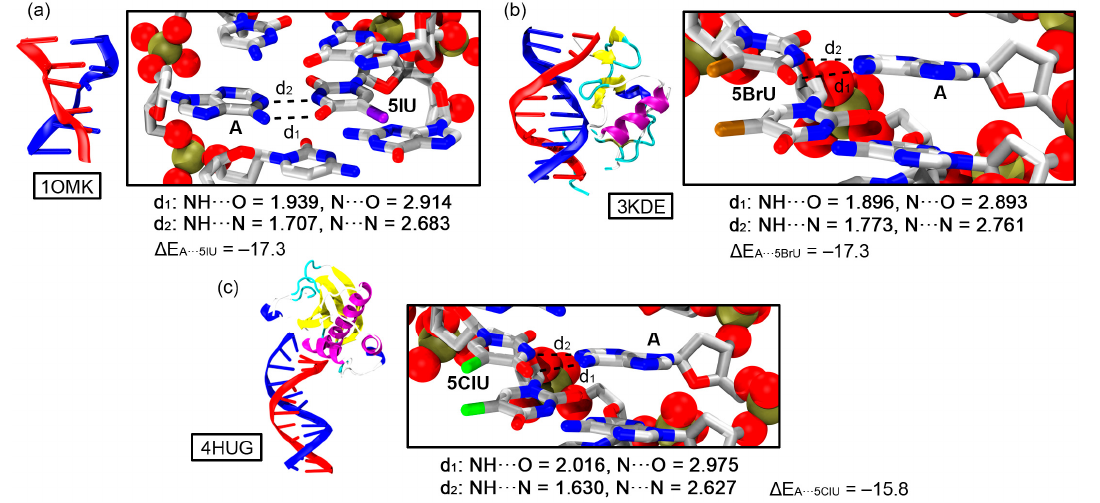
Figure 9. Partial views of X-ray structures exhibiting halogenated U···A BPs. The BP interaction is magnified inside the rectangular parts of the figure; 1OMK ( a ), 3KDE ( b ), and 4HUG ( c ). Distances are given in Å and energies in kcal/mol.